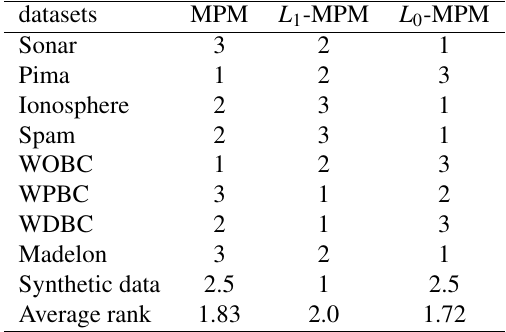
Table 4. Comparison with MPM and L 1 -MPM for ranks datasets